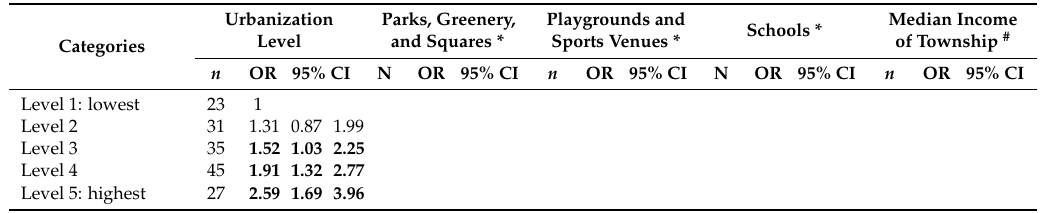
Table A1. The association of each ecological factors with regular